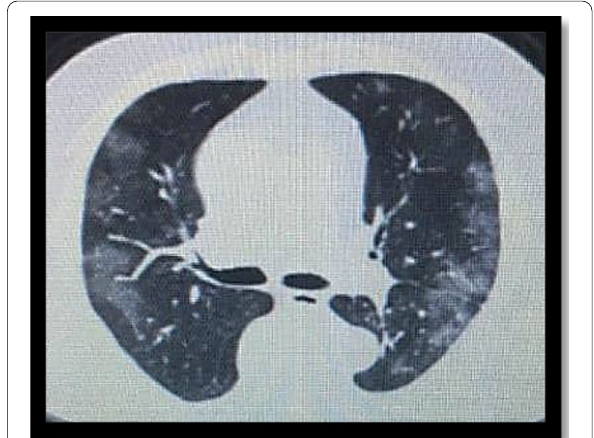
Fig. 3 Axial nonenhanced chest CT of the patient showing bilateral patches of ground‑glass opacities in a peripheral and sub‑pleural distribution, diagnosing COVID‑19